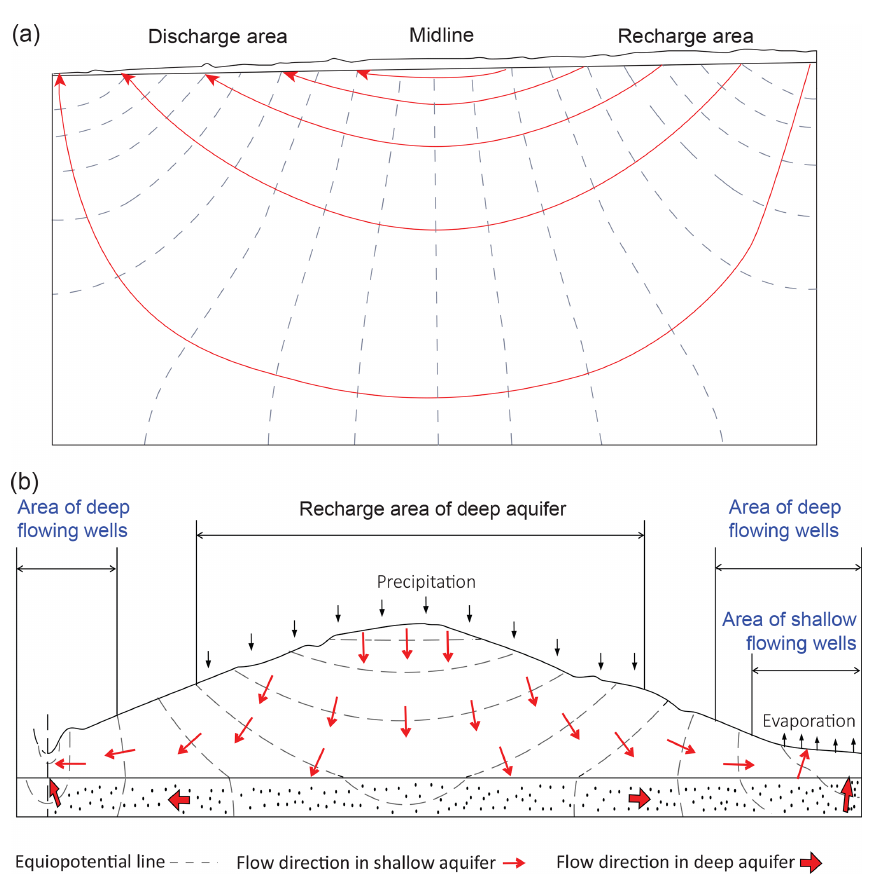
Figure 7. Topographically driven flow systems: (a) homogeneous basin (modified from Tóth, 1962) and (b) heterogeneous basin with a higher permeability layer in the bottom (modified from Meyboom,